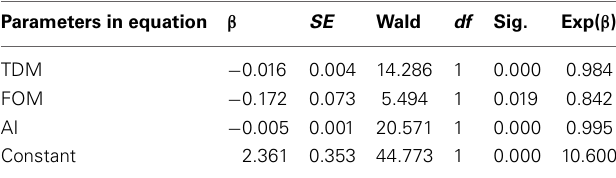
Table 2 | Primer sequences for RNAi. Genes Forward primer (5 (cid:2) –3 (cid:2)